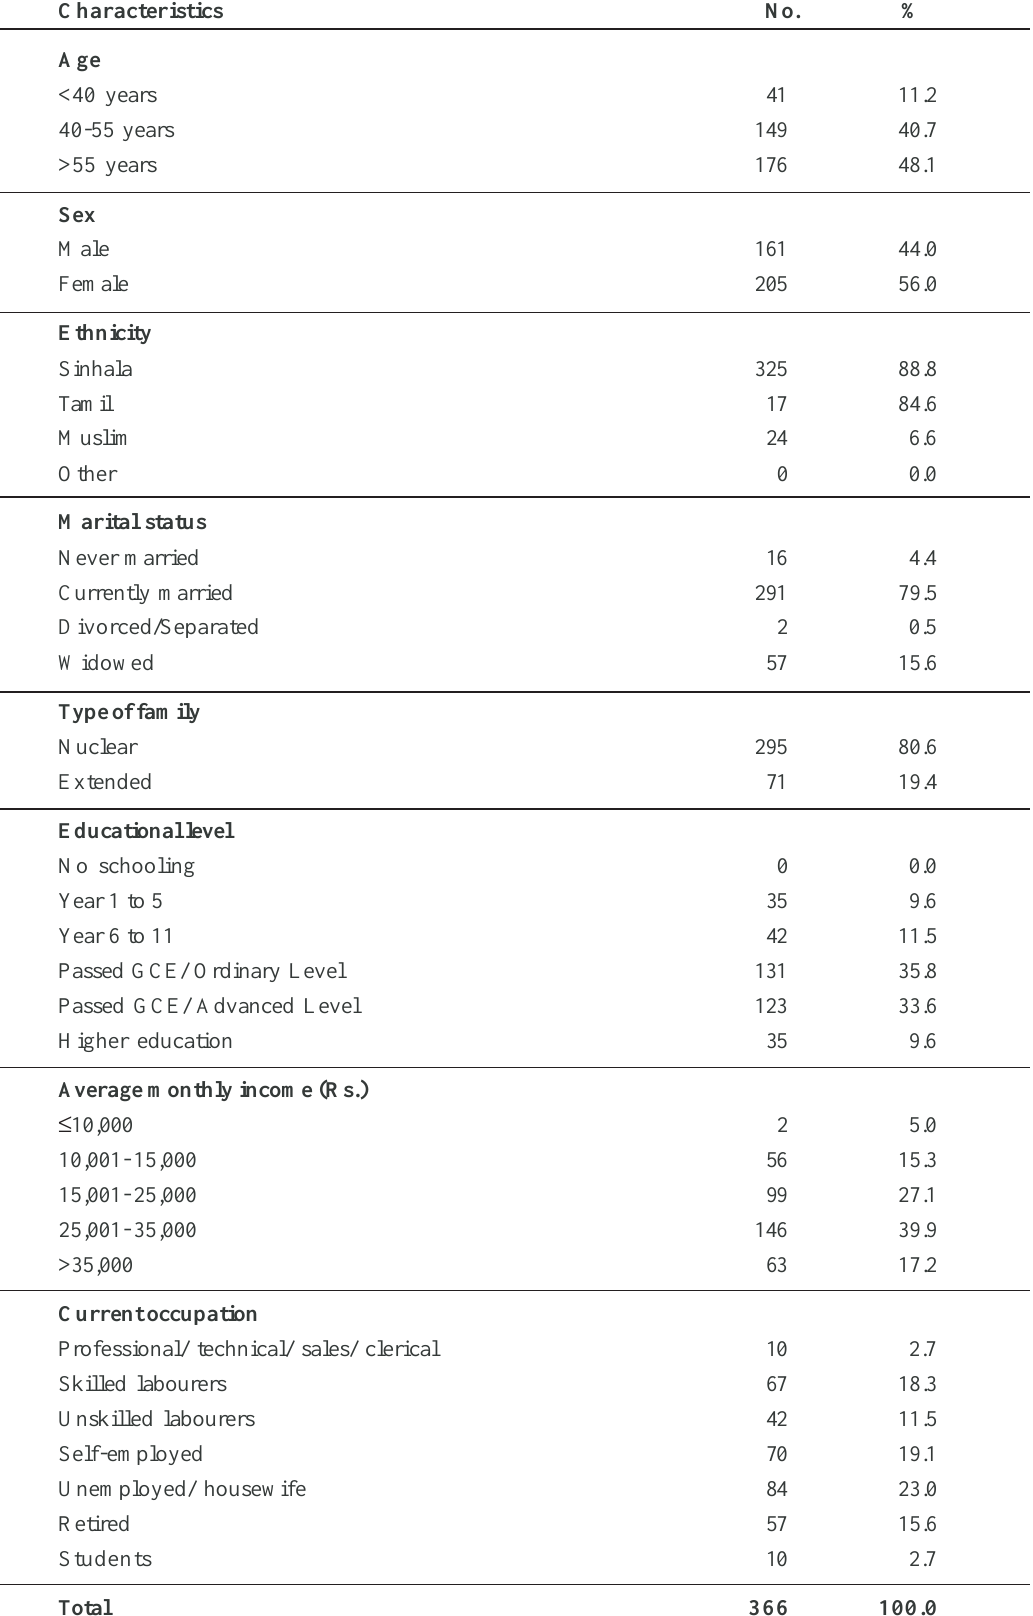
Table 1. Demographic and socio-economic characteristics of the clinic patients